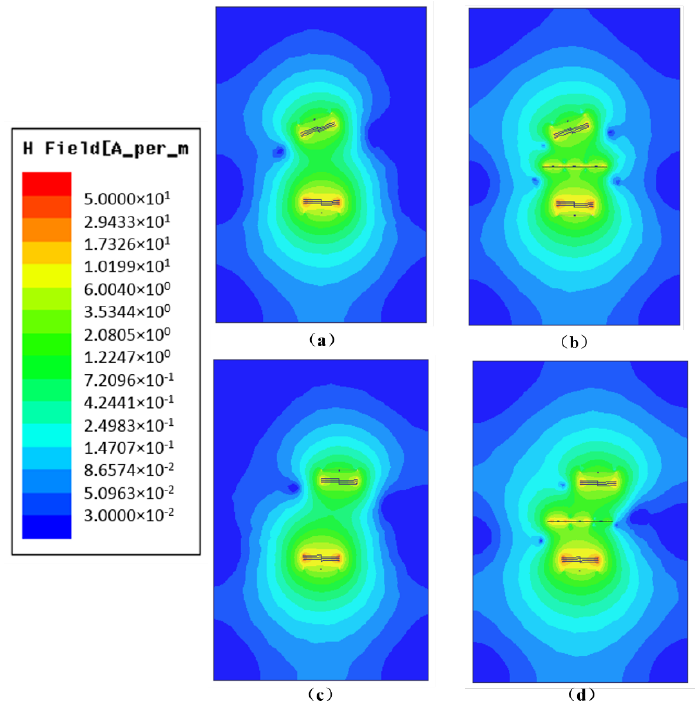
Figure 6. Comparison of magnetic field intensity before and after introducing NMM: ( a ) WPT system with angular offset, ( b ) the system in ( a ) and the system including NMM, ( c ) WPT system with lateral misalignment, and ( d ) adding NMM to ( c ).